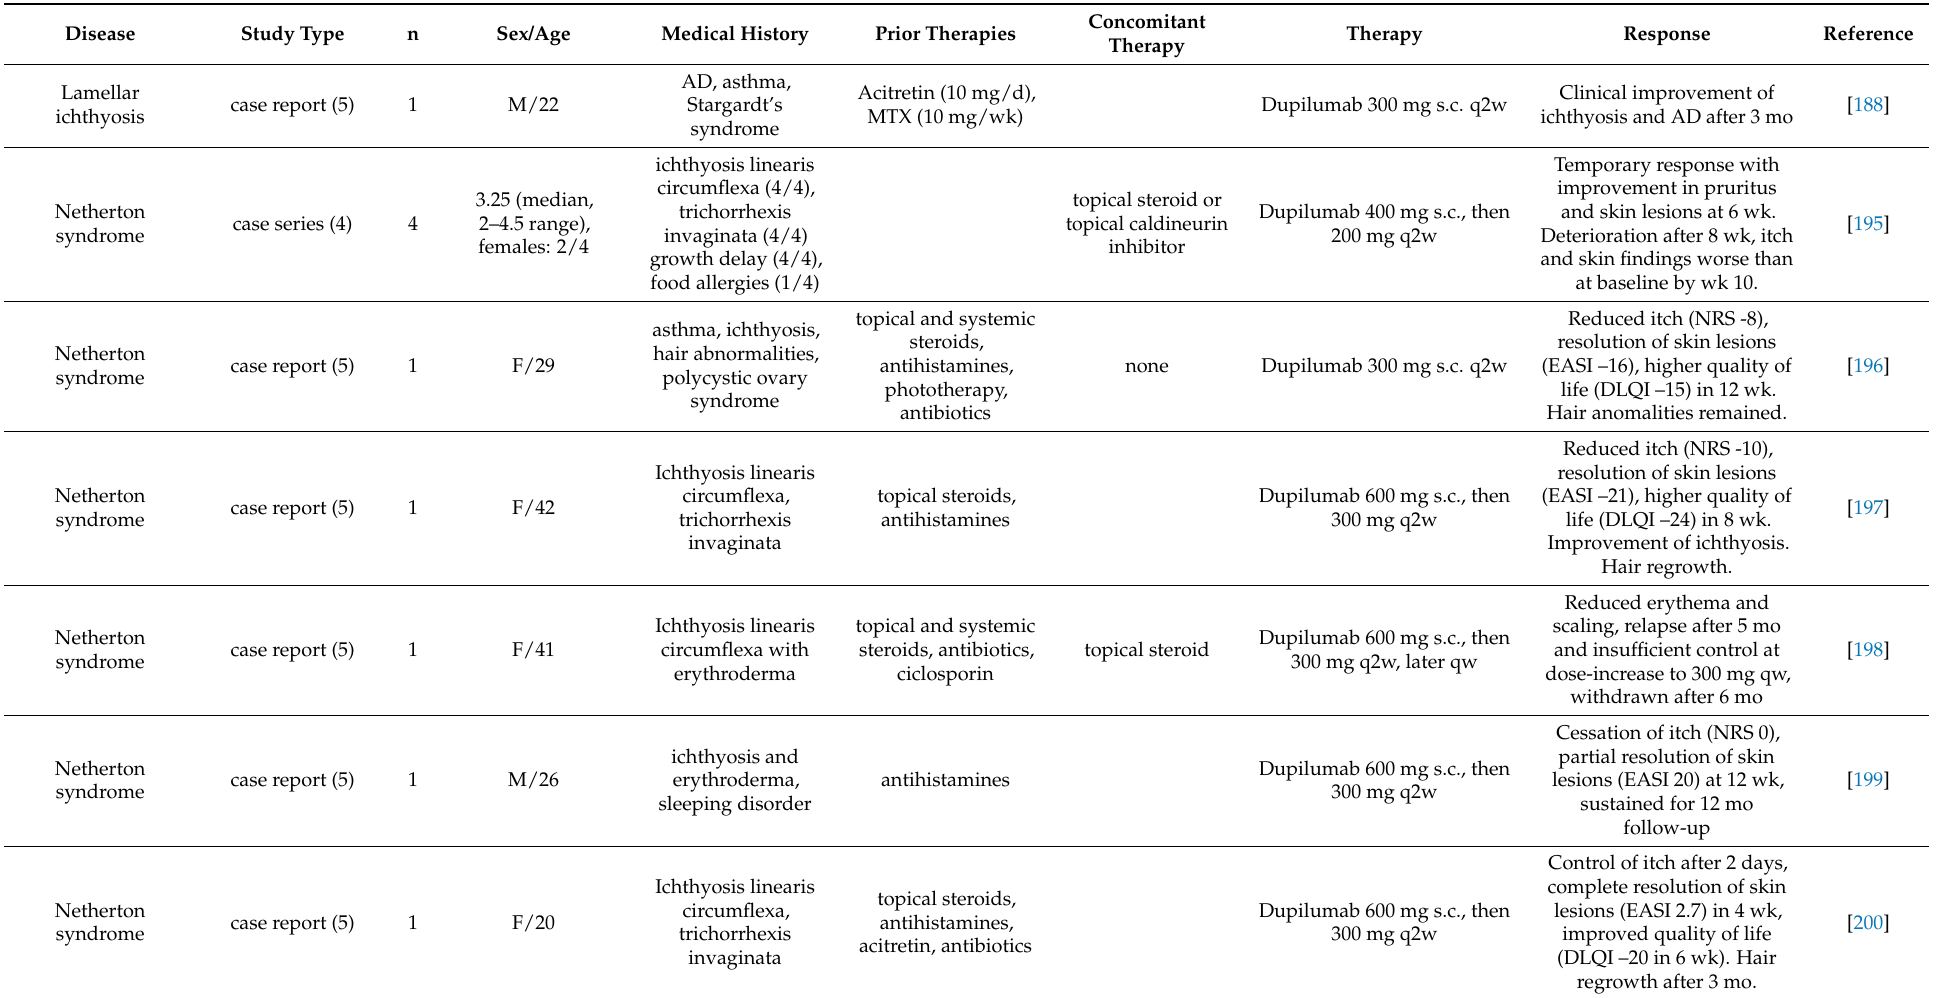
Table 6. Netherton syndrome and other hereditary skin